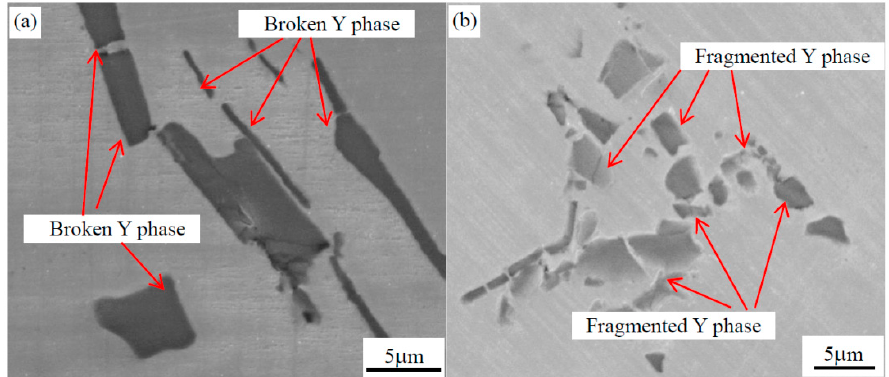
Figure 5. SEM images of the Y phase in AISI 321: ( a ) after second step forging, K L1 = 1.37; and ( b ) after third step forging, K L2 = 3.11.